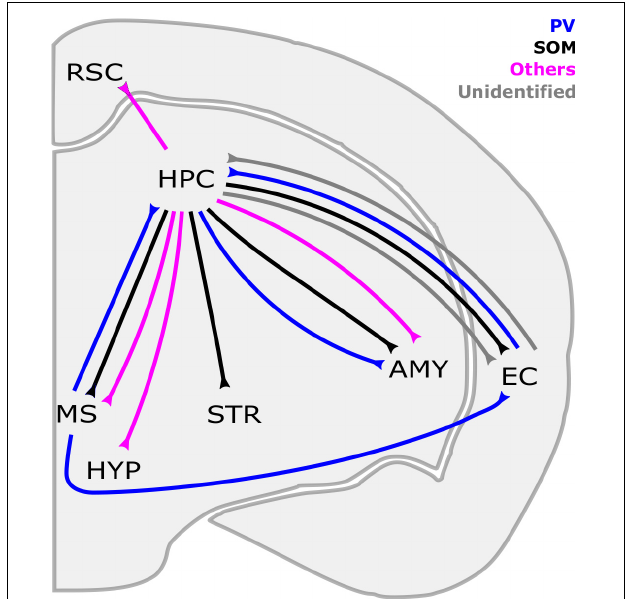
FIGURE 1 | Long-range GABAergic neuron (LRGN) projections to and from the hippocampus. The HPC is reciprocally connected with the EC and MS through SOM-LRGNs (HPC outputs) and PV-LRGNs (HPC inputs). Even a single LRGN in the MS can project to both the EC and HPC. In parallel, LRGNs that are identified by markers other than PV and SOM (magenta), such as Reelin/NPY, in the HPC send axons to the RSC. Inhibitory projections from the HPC to subcortical structures have been described, such as the STR and the AMY. HPC-AMY LRGNs are diverse in their neurochemical expression, including SOM, PV and others. The HPC also sends nNOS + LRGNs to the HYP and the MS. Contralateral projections are not included here. AMY, amygdala; EC, entorhinal cortex; HYP, hypothalamus; HPC, hippocampus; MS, medial septum; RSC, retrosplenial cortex; STR, striatum; PV, parvalbumin, SOM, somatostatin; NPY: neuropeptide Y; nNOS, neuronal nitric oxide